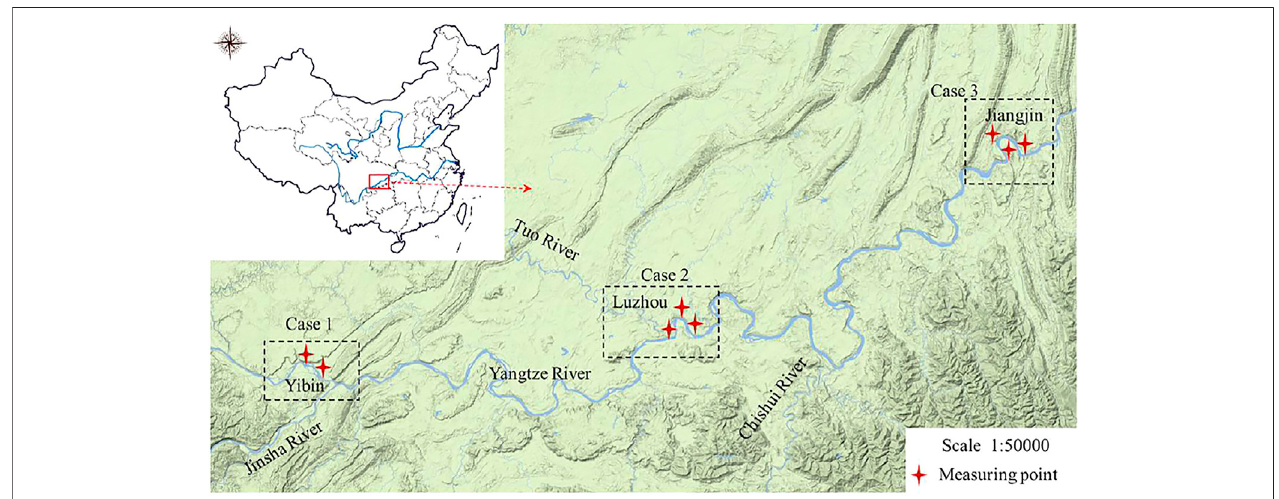
FIGURE 1 | Locations of the monitoring sites and major cities along the Yangtze River.